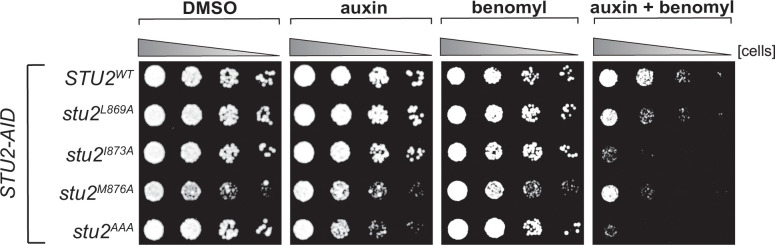
Cell viability assays for single residue hydrophobic-to-alanine mutations.STU2-AID cells expressing various STU2-3V5 alleles from an ectopic locus (STU2WT, M622; stu2L869A, M1576; stu2I873A, M1575; stu2M876A, M1574; stu2AAA, M1525) were serially diluted (fivefold) and spotted on plates containing DMSO, 500 μM auxin, 5 μg/mL benomyl, or 500 μM auxin + 5 μg/mL benomyl.